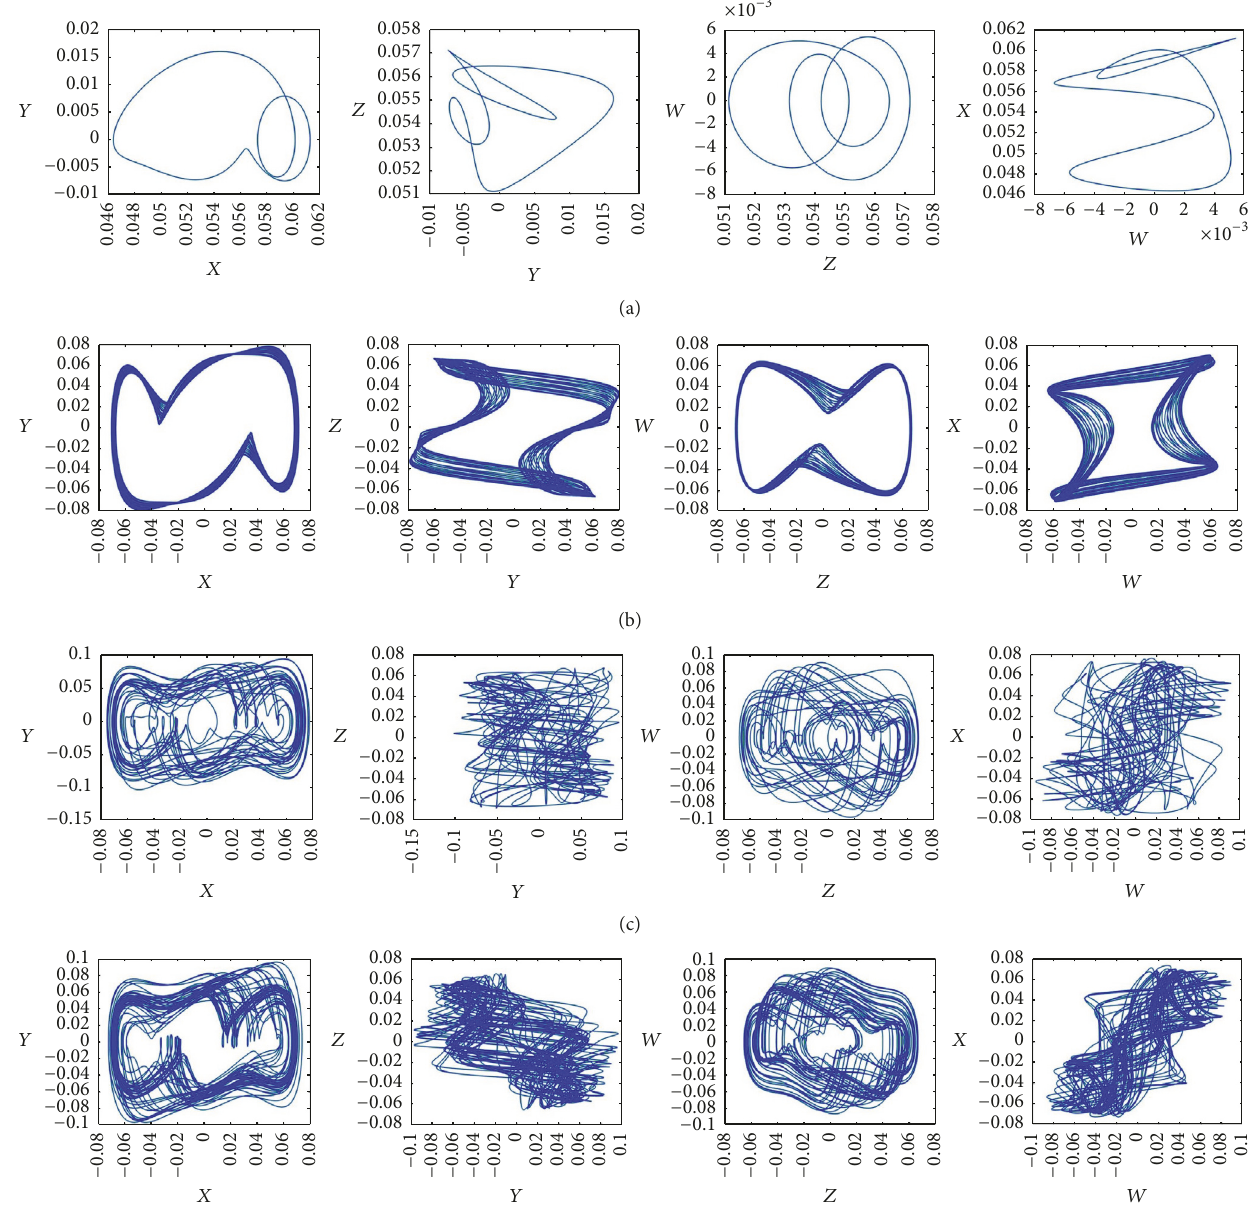
Figure 2: 2D phase portraits of the 2DOF SMA system: (a) periodic; (b) quasiperiodic; (c) chaotic; (d) hyperchaotic.